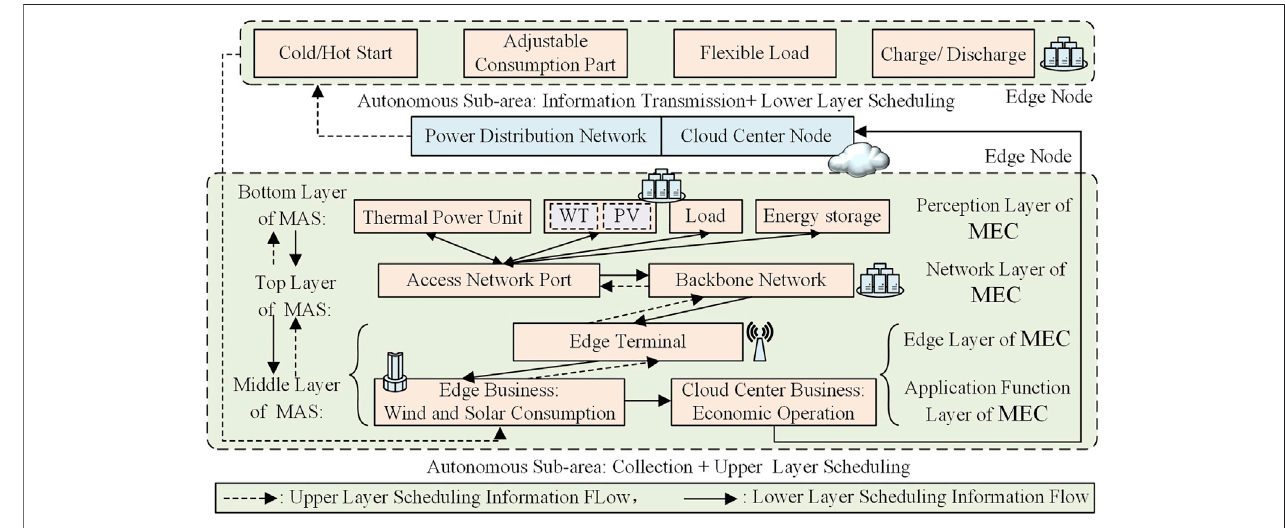
FIGURE 1 | Structure of the distributed power network based on